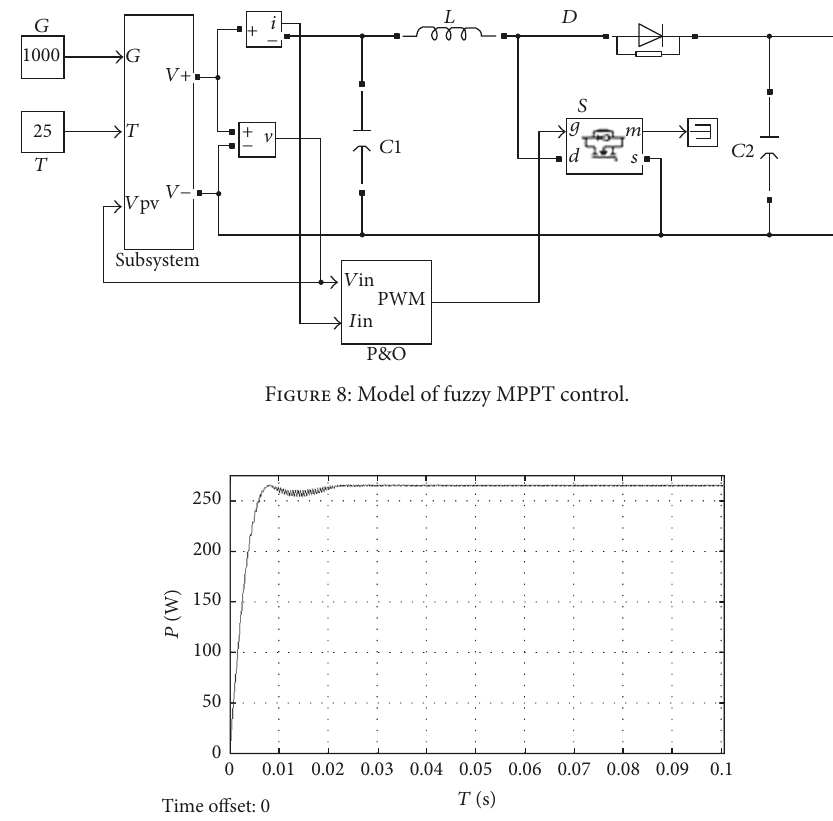
Figure 9: Output power of photovoltaic array.